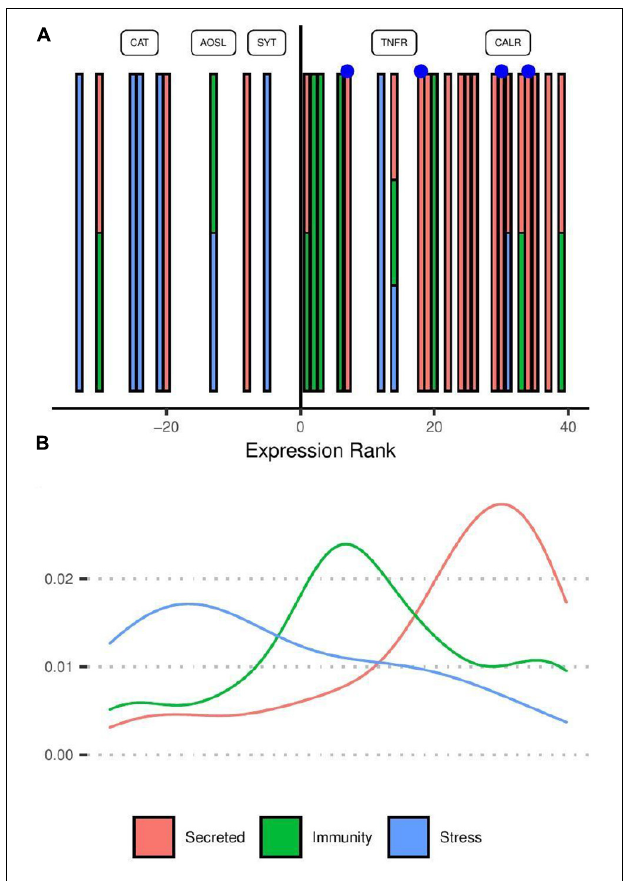
FIGURE 3 | Ranking distribution of differentially expressed transcripts under non-contact competition coloured by functional category. (A,B) Share the same colour scheme and horizontal axis. (A) Individual transcripts are shown as vertical bars positioned along the horizontal axis according to the rank of their effect size (log 2 fold change under competition compared with controls). Positive ranks represent transcripts up-regulated in competition compared to controls. Transcripts belonging to multiple categories are shown as multi-coloured bars. Blue points represent putative toxins. Category “Stress” includes transcripts associated with response to reactive oxygen species as well as those involved in the unfolded protein response. Labelled points correspond to transcripts with strong evidence of homology to named proteins. CAT, catalase; AOSL, allene oxide synthase-lipoxygenase; SYT, synaptotagmin-like; TNFR, tumor necrosis factor receptor; CALR, calreticulin. (B) Smoothed density plot showing the density of genes in each category according to expression